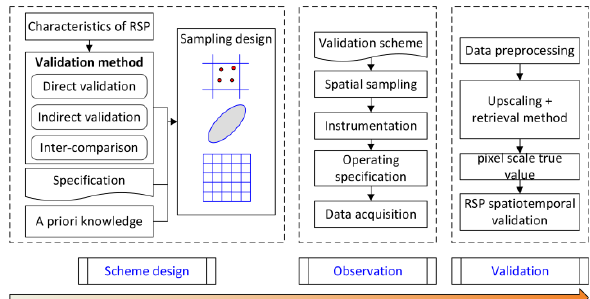
Figure. 2 The flowchart of building of the technical specifications